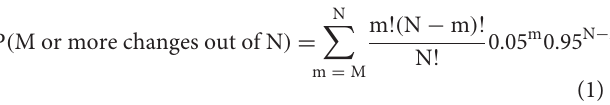
for example, the approach used to maintain the same stimulus coil location before and after the wearable device session